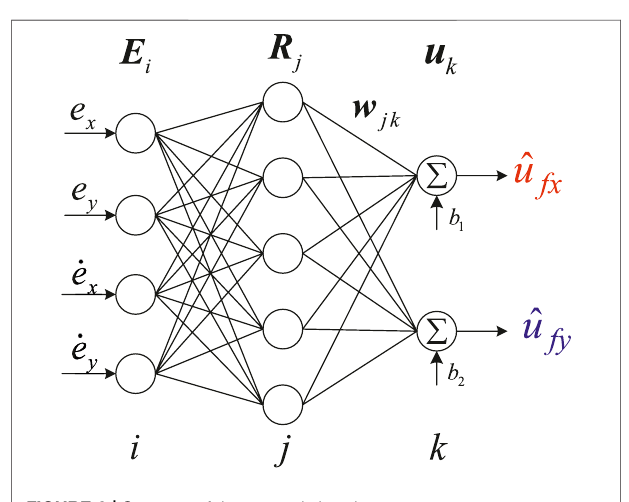
FIGURE 3 | Structure of the uncertainties observer.